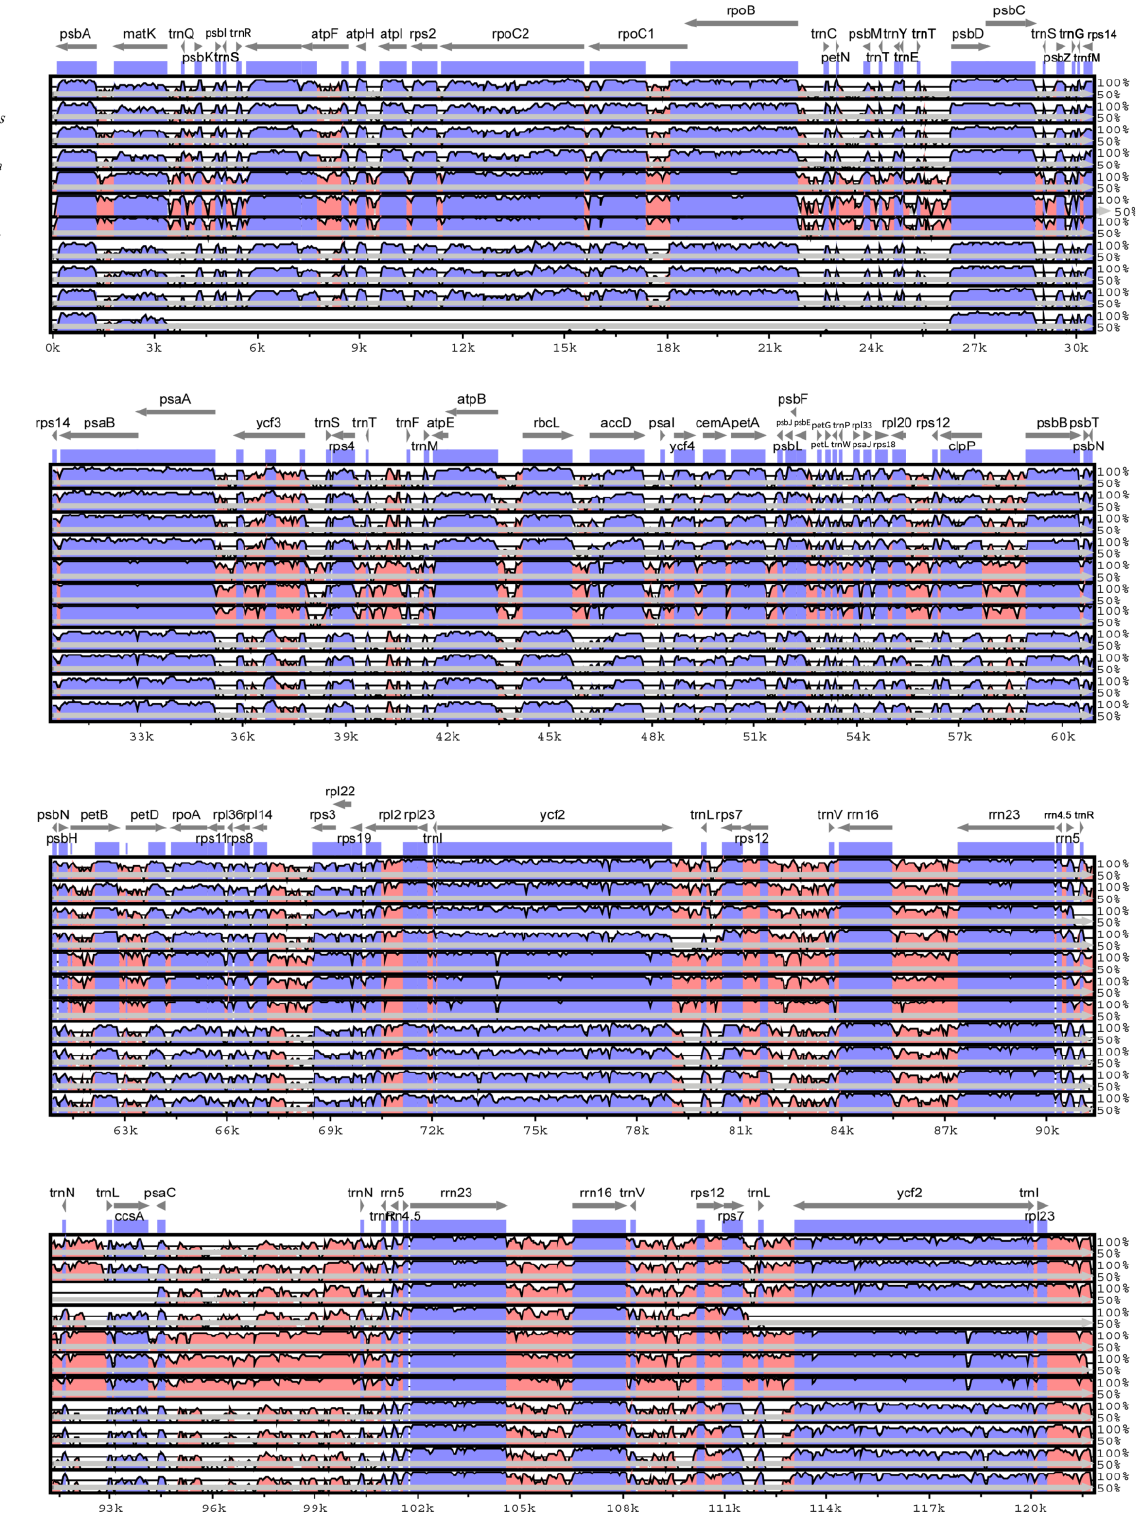
Figure 3. Comparison of the chloroplast genomes of the 12 species, using S. parasitica as a reference in mVISTA program.